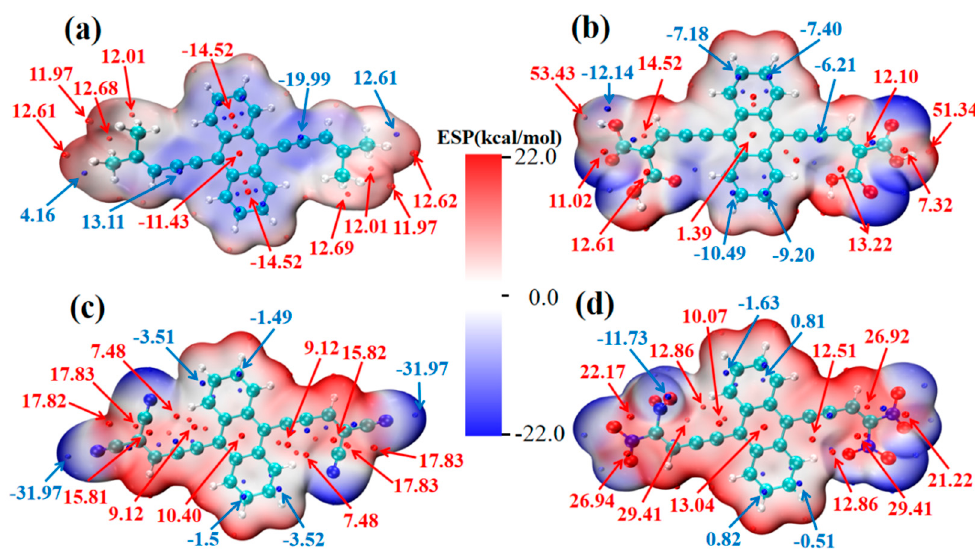
Figure 5. The molecular electrostatic potential vdW isosurface and its extreme points of -H ( a ), -COOH ( b ), -CN ( c ) and -NO 2 ( d ) conjugated molecular systems. The red and blue regions represent the positive and negative electrostatic potential,